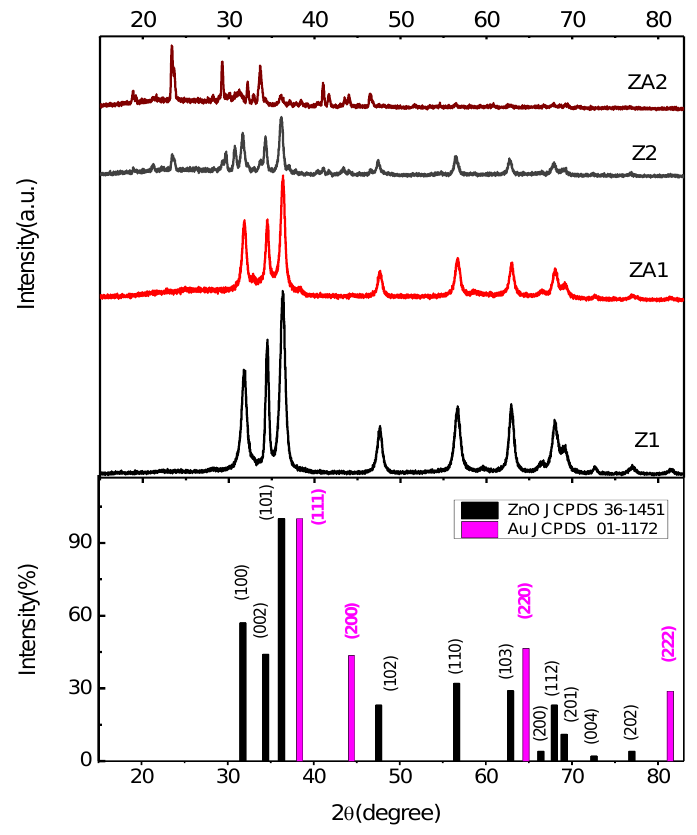
Figure 2. XRD patterns of ZnO and ZnO/Au nanomaterials.